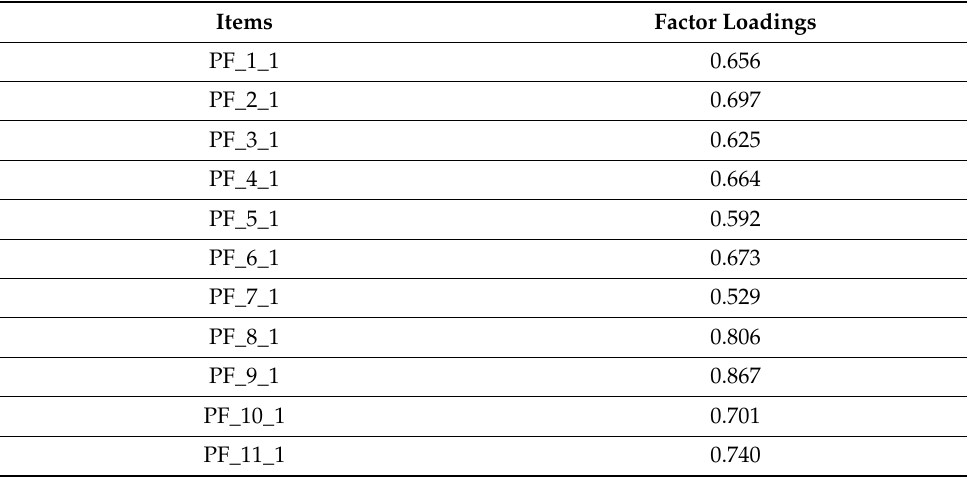
Table 6. Factor loading of 11-item